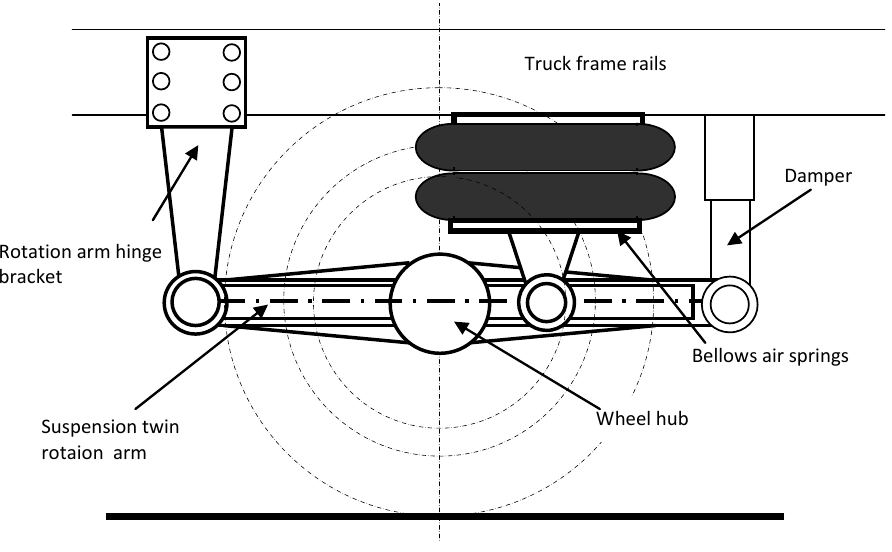
Figure 1. An example of a solution design of a rear air spring truck or trailer suspension. A most common engineering design for composite structure bellows air springs (steel braid and